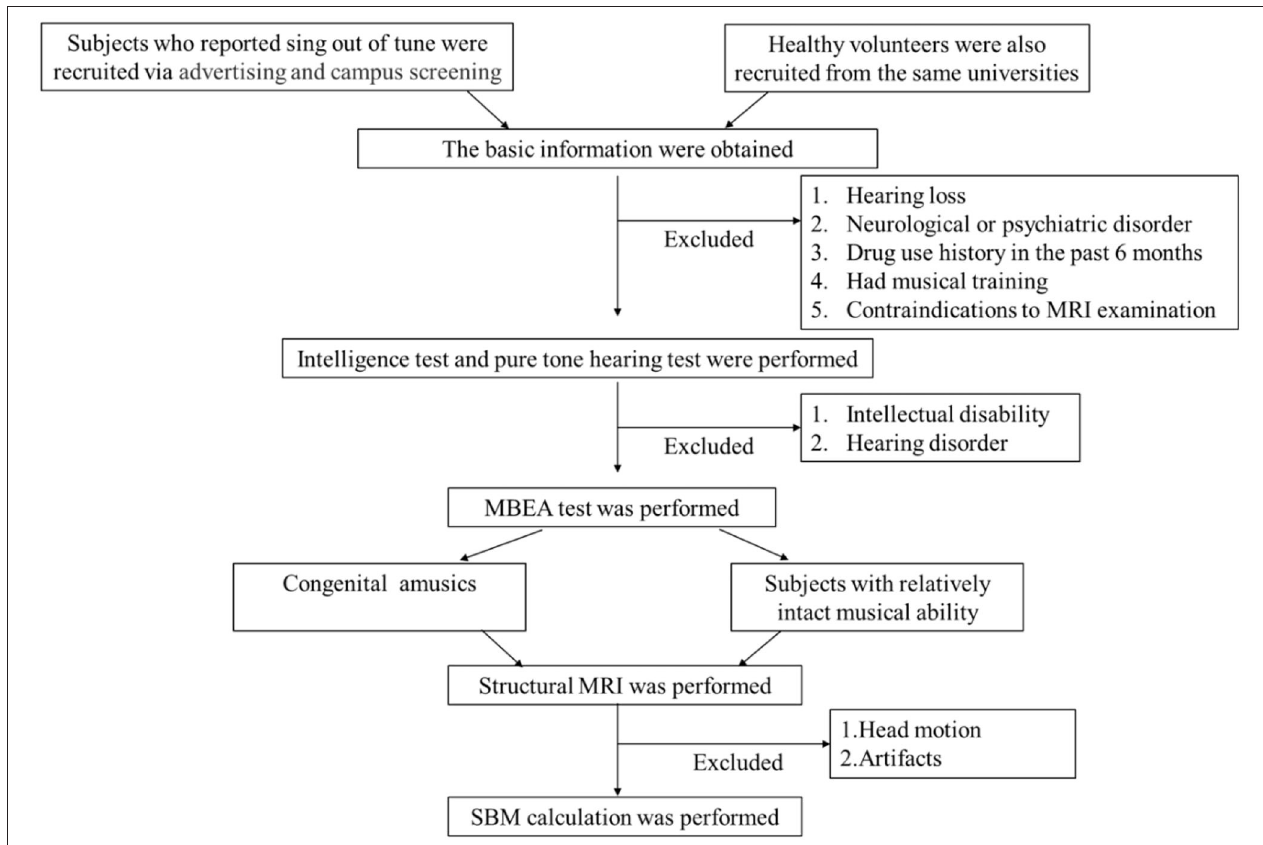
FIGURE 1 | Flowchart of patient selection. MRI, magnetic resonance imaging; MBEA, the Montreal Battery of Evaluation of Amusia; SBM, surface-based morphology.